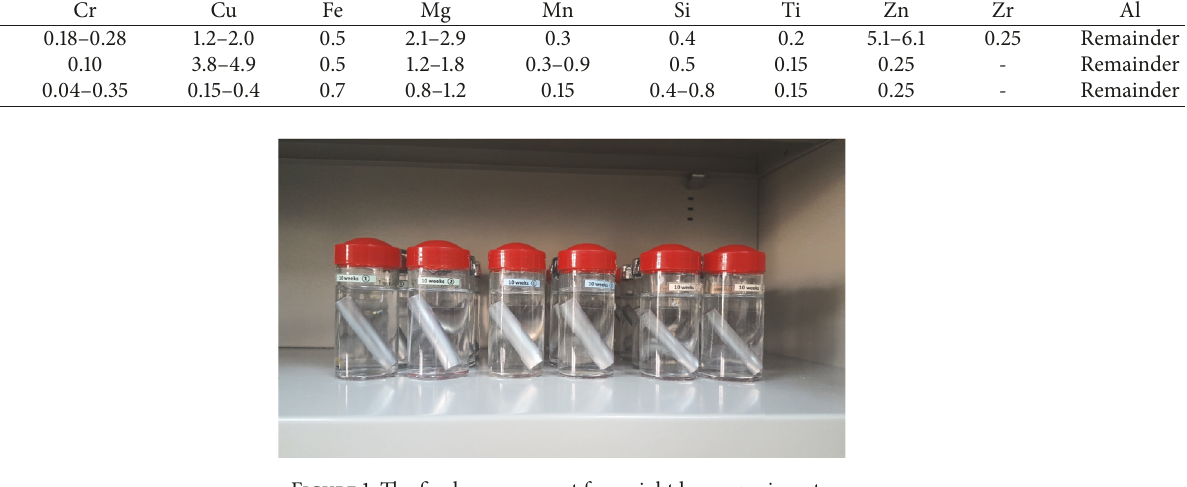
Figure 1: The final arrangement for weight loss